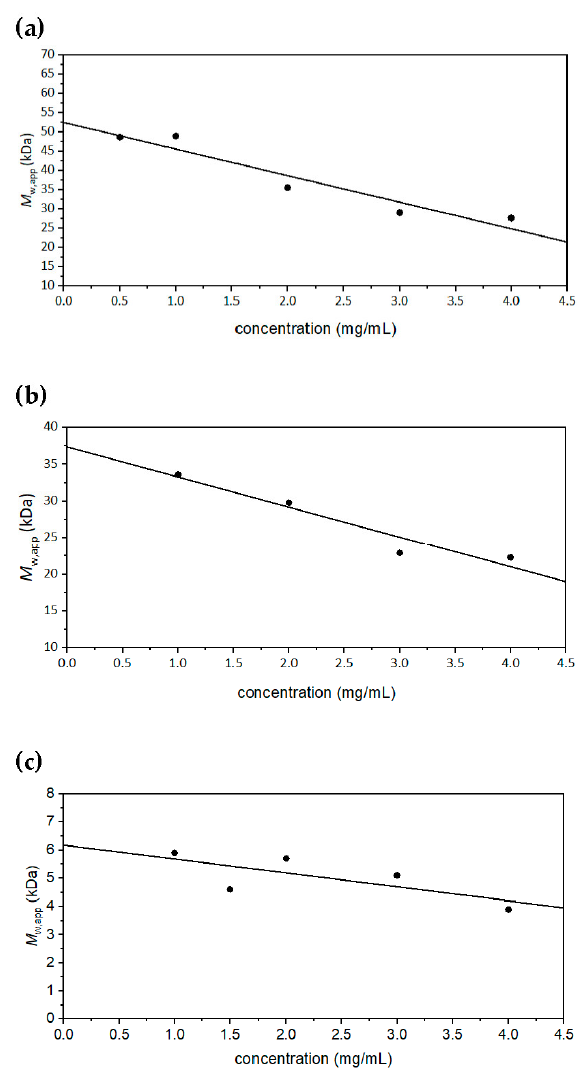
Figure 7. Dependence of apparent M w,app from sedimentation equilibrum using SEDFIT-MSTAR on concentration, with an extrapolation to obtain the thermodynamically ideal M w,app of the PDMS-OH siloxanes in isopropanol. ( a ) PS36000, rotor speed = 22,000 rpm, temperature = 20.0 °C. The value extrapolated to zero concentration was calculated to be M w = (52.5 ± 3.0) kDa. ( b ) PS18000 in isopro- panol, rotor speed = 30,000 rpm. M w = (37.4 ± 2.3) kDa. ( c ) PS4200 in isopropanol, rotor speed = 49,500 rpm. M w = (6.2 ± 0.7) kDa.